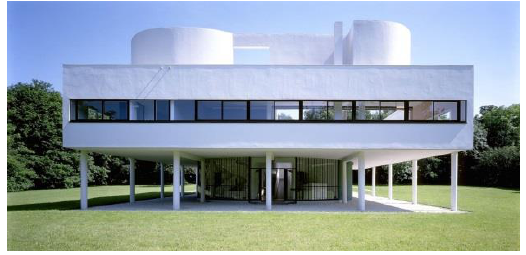
Fig. 30 Villa Savoye (Poissy, 1928-31)